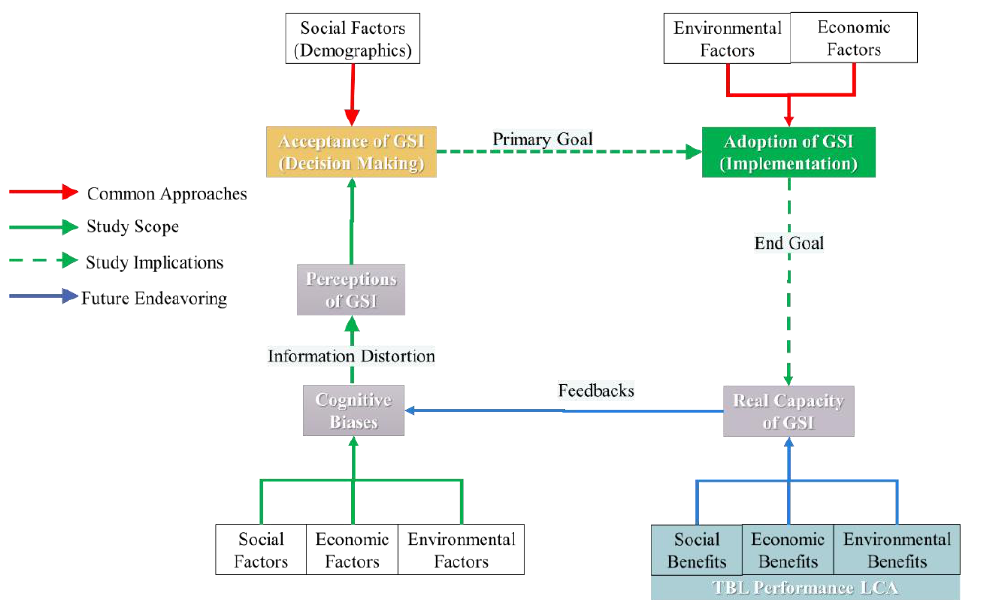
Figure 3. The conceptual framework proposed in this study.